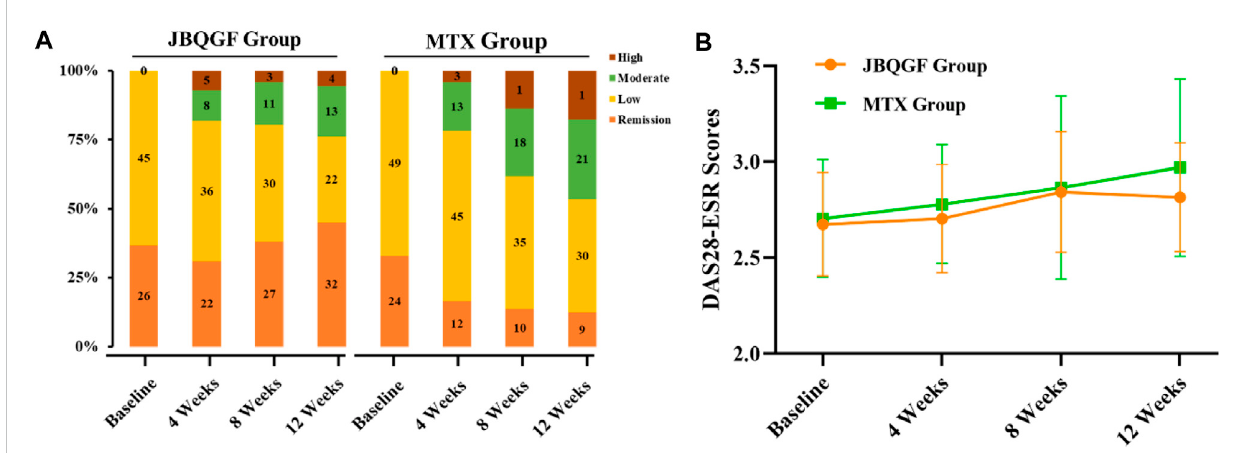
FIGURE 3 Differences in DAS28-ESR distributions (A) and trends in test scores (B) between the two